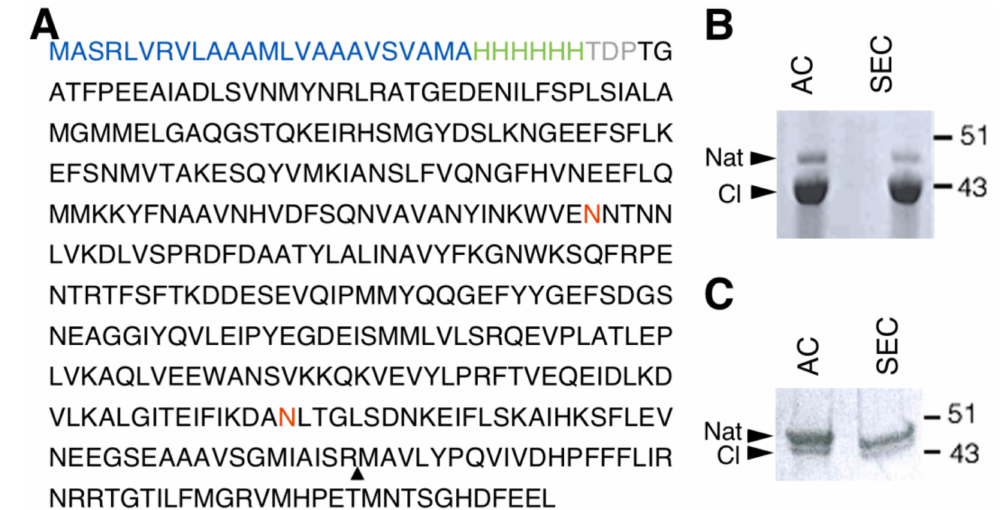
Figure 1. Human glycosylated NS (gNS) expression and purification in LEXSY. ( A ) Primary sequence of the construct used for gNS expression in LEXSY (UniProtKB - Q99574). The signal peptide sequence is colored in blue, the HisTag is green and the spacer in grey. The neuroserpin (NS) sequence is black, the glycosylation sites are in red and the triangle highlights the protease cleavage site. ( B ) SDS-PAGE analysis of gNS purification after AC and SEC chromatographic steps according to the protocol shown in Figure S1A. ( C ) SDS-PAGE analysis of optimized gNS purification after the AC and SEC chromatographic steps (see also Figure S1B). Abbreviations: Nat: native; CL: cleaved; AC: a ffi nity chromatography; SEC: size exclusion